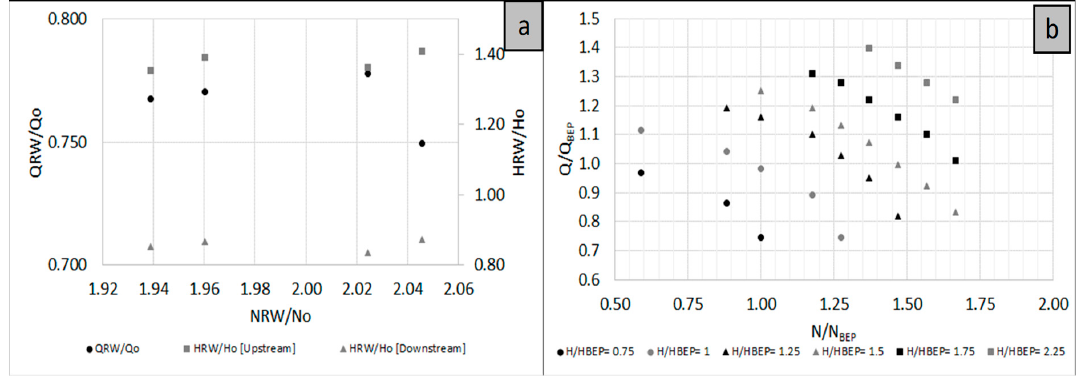
Figure 14. ( a ) (cid:1843) RW / (cid:1843) 0 and H RW / H 0 as a function of N RW / N 0 and ( b ) (cid:1843) / (cid:1843) BEP as a function of N / N BEP and Figure 14. ( a ) Q RW / Q 0 and H RW / H 0 as a function of N RW / N 0 and ( b ) Q / Q BEP as a function of N / N BEP H / H BEP for the radial machine. and H / H BEP for the radial machine. Figure 14. ( a ) 𝑄 RW / 𝑄 0 and H RW / H 0 as a function of N RW / N 0 and ( b ) 𝑄 / 𝑄 BEP as a function of N / N BEP and H / H BEP for the radial machine.